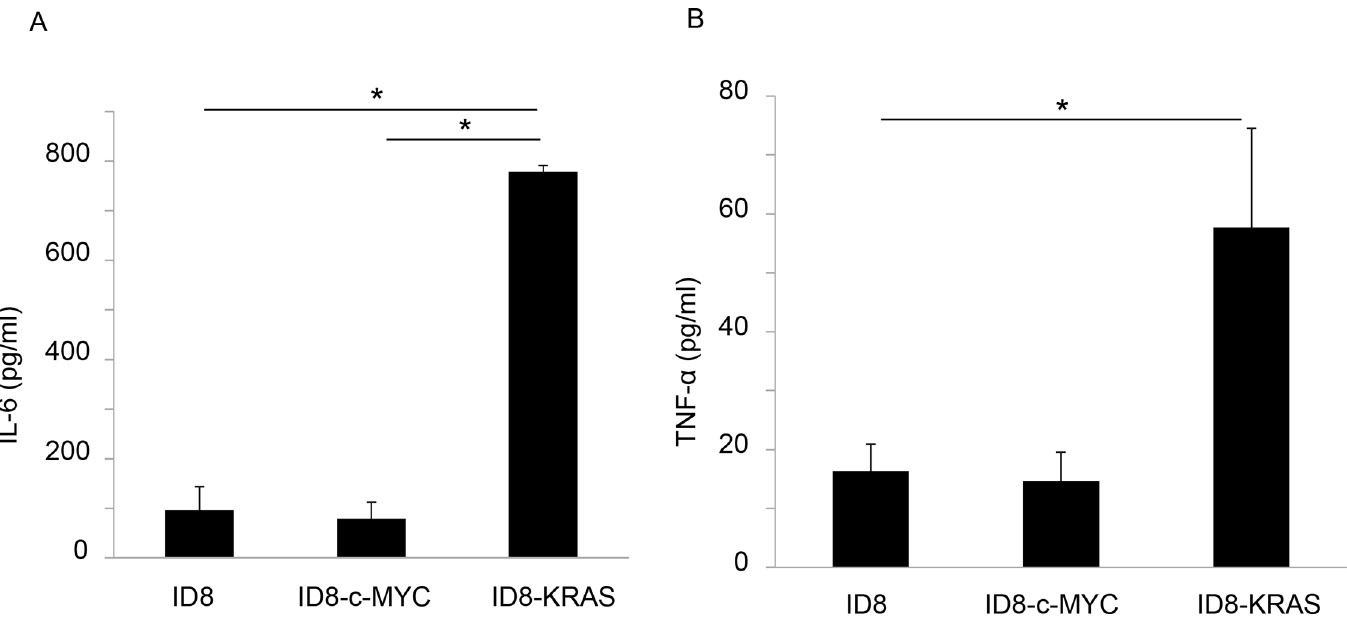
Fig 3. Inflammatory cytokines in ascites. ID8, ID8-c-MYC, or ID8-KRAS cells (2 × 10 6 ) were intra-peritoneal injected into C57/BL6 mice. Mice were sacrificed when the body weight reached 23 g and ascites were collected (ID8, ID8-c-MYC, and ID8-KRAS: n = 10). IL-6 (A) and TNF- α (B) concentration of ascites were assessed with specific ELISA. Error bars represent the mean ± SEM. A statistical analysis was performed with the Student ’ s t -test ( * P (cid:1) 0.05, ** P (cid:1) 0.01).